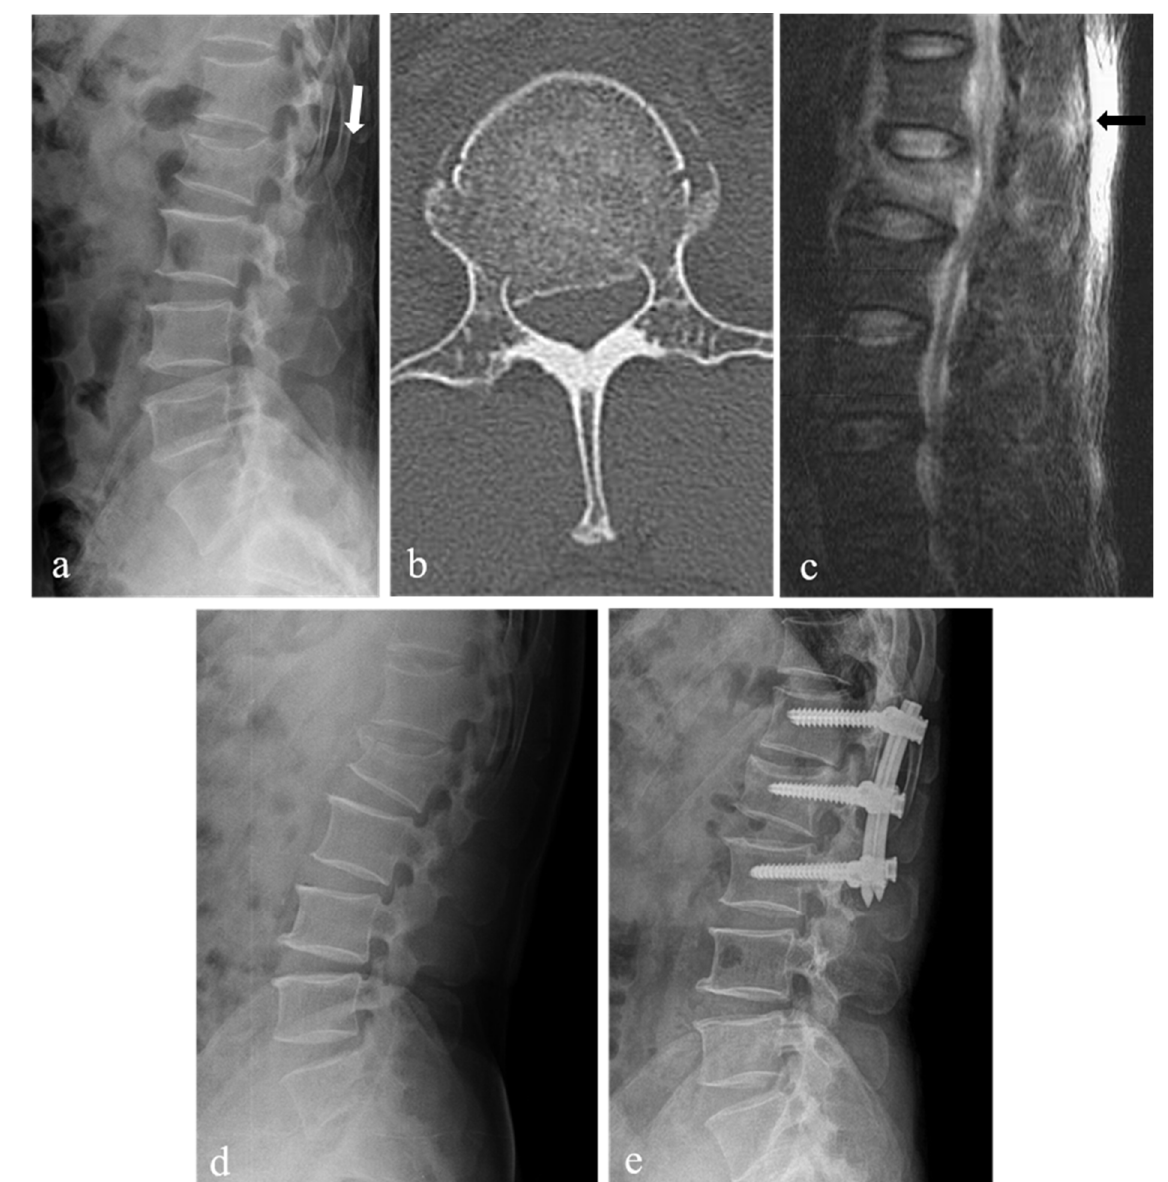
Figure 4. L1 burst fracture of a 52-year-old male patient with intact neurological status. Lateral X-ray ( a ) showing L1 burst fracture with a widening of the T12-L1 interspinous space (white arrow), kyphotic angle of 10 degrees, and loss of vertebral body height of 22%. Axial 2-dimensional (2-D) computed tomography (CT) scan ( b ) showing spinal canal compromise of 39%. T2-weighted sagittal magnetic resonance imaging ( c ) showing signal change (black arrow) without clear rupture of the posterior ligamentous complex. Follow-up lateral X-ray ( d ) showing the increased collapse of L1 body with a kyphotic angle of 19 degrees and loss of vertebral body height of 36%. This patient underwent surgery 12 days after injury due to rapidly progressive L1 body collapse, decreased height, and increased pain. Postoperative lateral X-ray ( e ) showing T12-L1-2 percutaneous posterior fixation. Table 1. Preoperative demographic data.